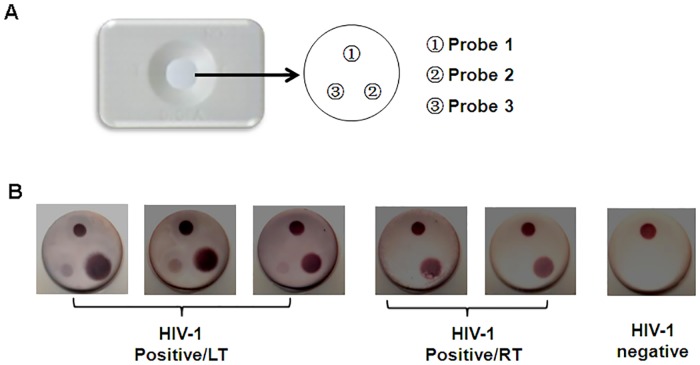
The diagram of sampling location and results of DIGFA.(A) the diagram of sampling location (B) the result photos of panel 1. three long-term infections (>1year) (left); two recent infections (< 4 months) (middle); one HIV negative (right).